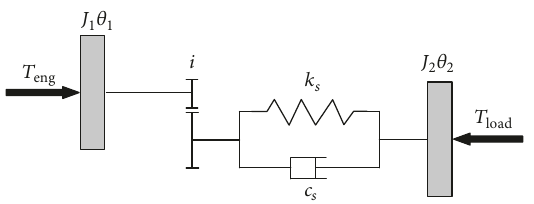
Figure 18: Structure of two degree-of-freedom vehicle longitudinal vibration